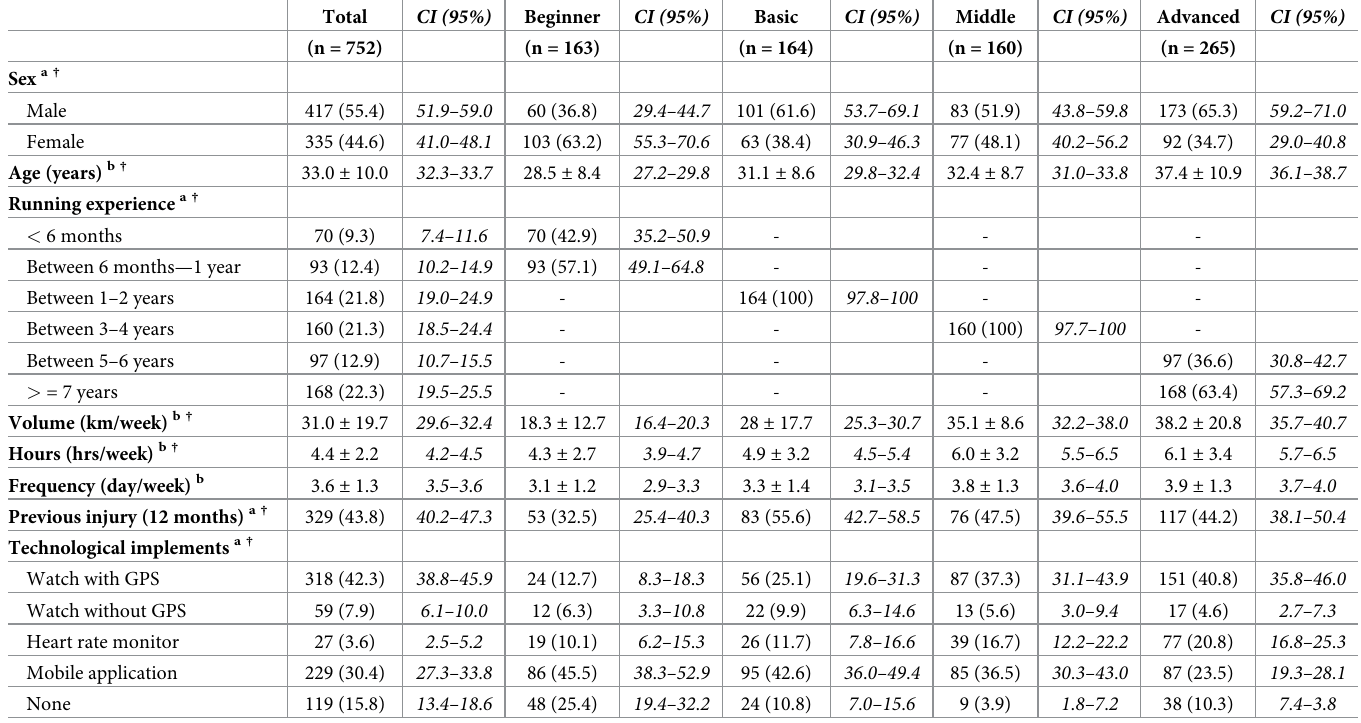
Table 2. Profiles characterization according to statistically significant and clinically relevant variables in SeRUN 1 study